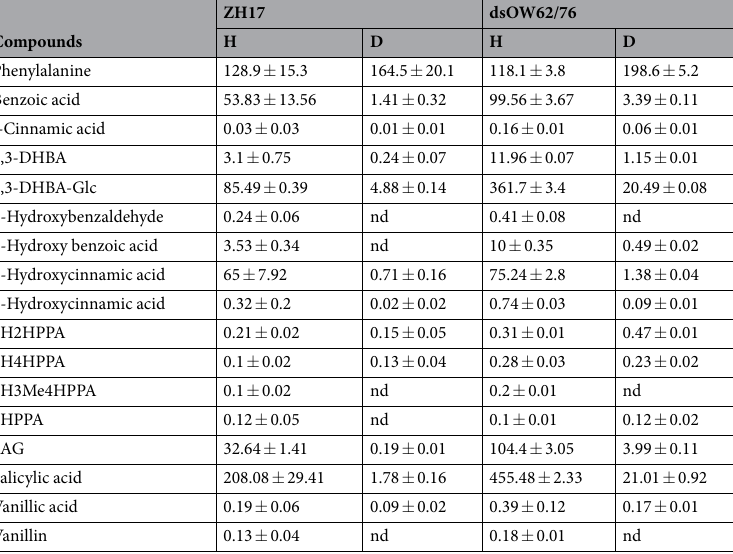
Table 1. Analysis of the compounds labeled by 2 H isotope in rice leaves fed with [ 2 H 8 ]Phe for 12 h. nd, not detected; D for deuterium labeled and H for non isotope labeled compounds; The internal standard was [ 2 H 6 ]ABA (10 ng). Data are means ± SE of three replicates. The experiments were repeated three times with similar results. The metabolite contents presented were normalized ng mg − 1 DW. Abbreviations: 2,3-DHBA, 2,3-dihydroxylbenzoic acid; 2,3-DHBA-Glc, 2,3-DHBA glucoside; 3H2HPPA, 3-hydroxy-(2-hydroxyphenyl) propionic acid; 3H4HPPA, 3-hydroxy-(4-hydroxyphenyl) propionic acid; 3H3Me4HPPA, 3-hydroxy- (3-methoxy-4-hydroxyphenyl) propionic acid; 3HPPA, 3-hydroxy-3-phenylpropionic acid; SAG, salicylic acid